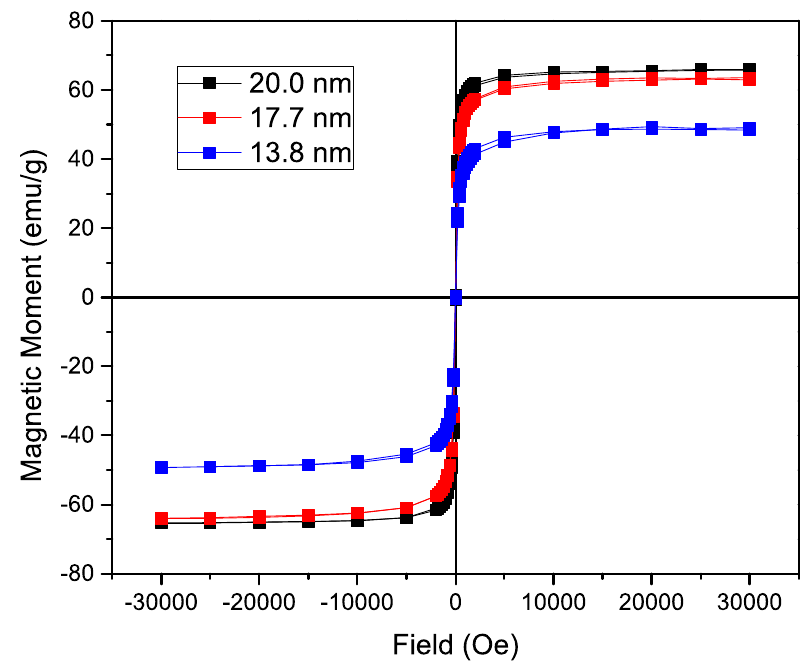
Figure 3. Magnetization of the nanoparticles coated with n-octylamine showing a hysteresis curve with no coercivity or magnetic remanence. A significant increase in saturation magnetization is observed directly proportional to the size of the iron oxide nanoparticles (IONP).